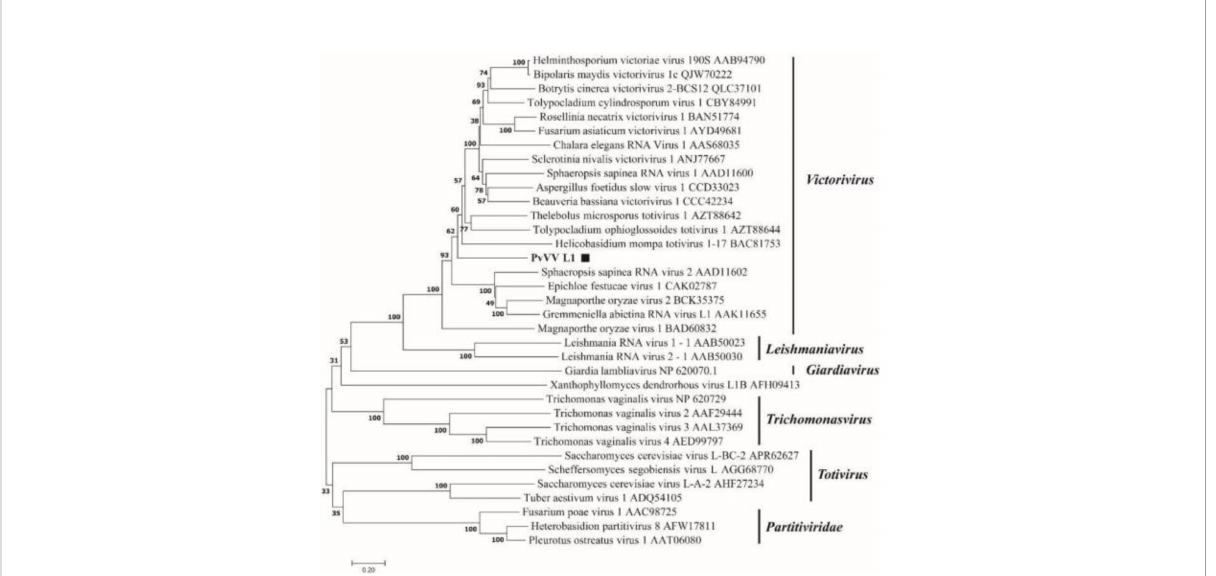
FIGURE 17 Phylogenetic analysis of PvVVL1. The phylogenetic tree was constructed based on the viral CP aa sequences using the neighbor-joining (NJ) method in MEGA 7 and the Poisson model. The scale bar represents a genetic distance of 0.2 aa substitutions per site. Black squares indicate the novel mycoviruses PvVVL1 identi fi ed in the present